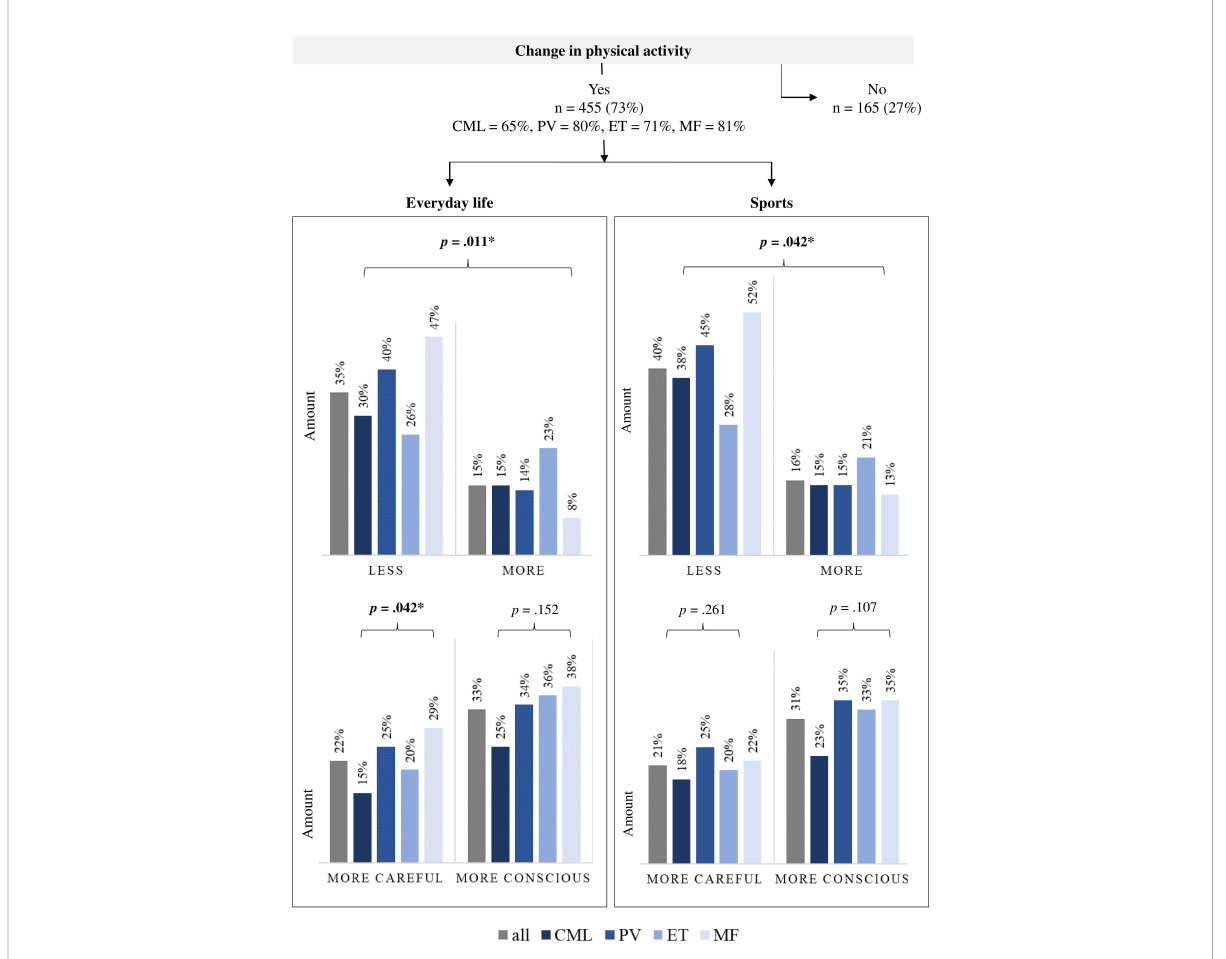
FIGURE 2 In fl uence of a myeloproliferative neoplasia disease on self-reported physical activity (n = 620). n, number of patients; CML, chronic myeloid leukemia (n = 169); PV, polycythemia vera (n = 166); ET, essential thrombocythemia (n = 155); MF, myelo fi brosis (n = 117). Bold: statistically signi fi cance, * p ≤